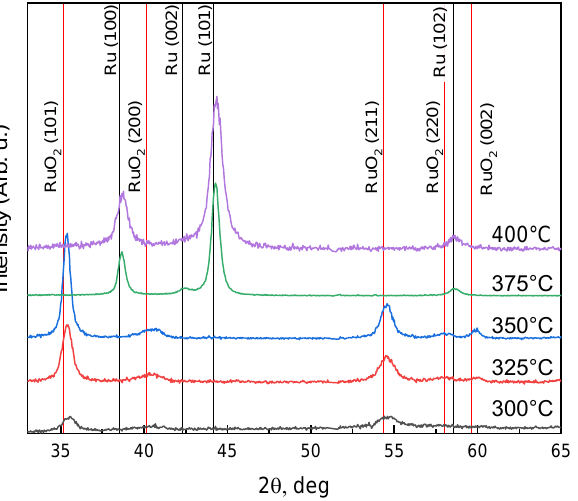
Figure 2. Grazing incidence XRD (GXRD) spectra obtained for the coatings deposited at temperatures 300–400 °C.